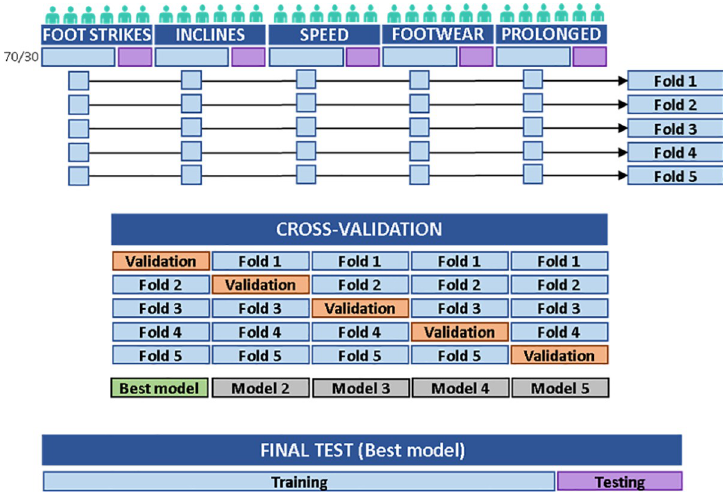
Fig 4. Data flow. From each dataset, 30% of the participants were extracted, concatenated and left aside as test set for model testing (22 participants, 8712 cycles). The remaining 70% of the participants were divided in five groups and concatenated in five folds with a representative number of participants from each dataset (10 to 14 participants each, 4999 ± 842 cycles in each fold). These five folds were used for cross-validation, whereby five models (i.e. sets of parameters) were developed using four folds for training and the remaining fold for validation, with a different validation fold for each model. The best performing model was selected, retrained using the five folds altogether and then tested on the test